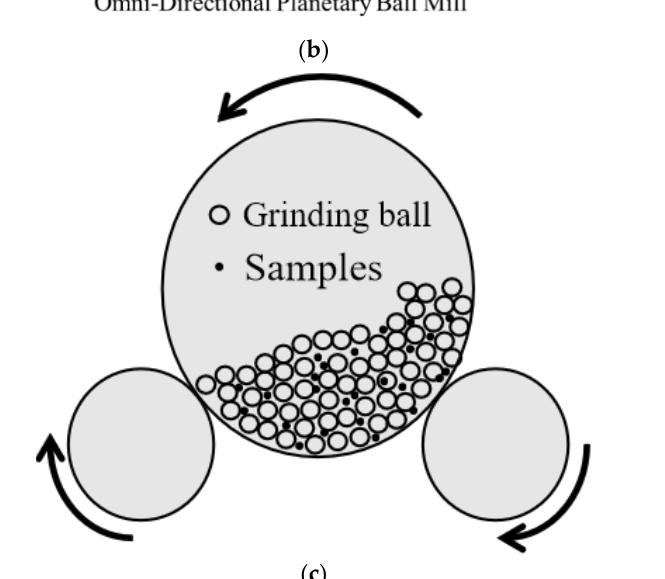
Figure 1. ( a ) Pyrolysis [34] Reprinted/adapted with permission from Ref. [34]. 2022, Chemical Engineering Journal; ( b ) 1st [34] Reprinted/adapted with permission from Ref. [34]. 2022, Chemical Engineering Journal; ( c ) 2nd mechanochemical activation technology.